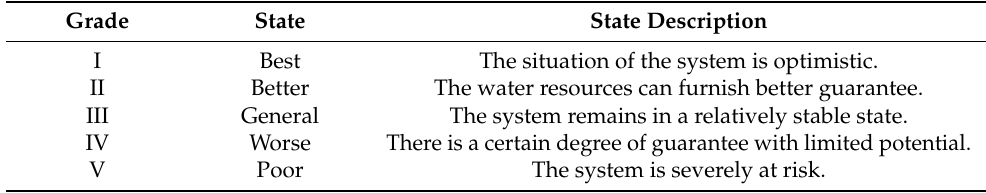
Table 4. Grade classification and state